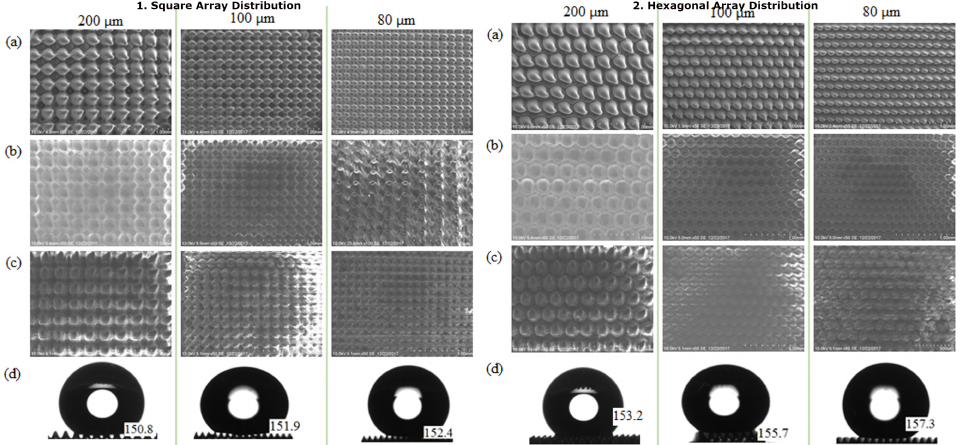
Figure 9. SEM images of: ( a ) SU8 micropillar, ( b ) PDMS microhole, ( c ) PDMS micropillar, and ( d ) water contact angle values.